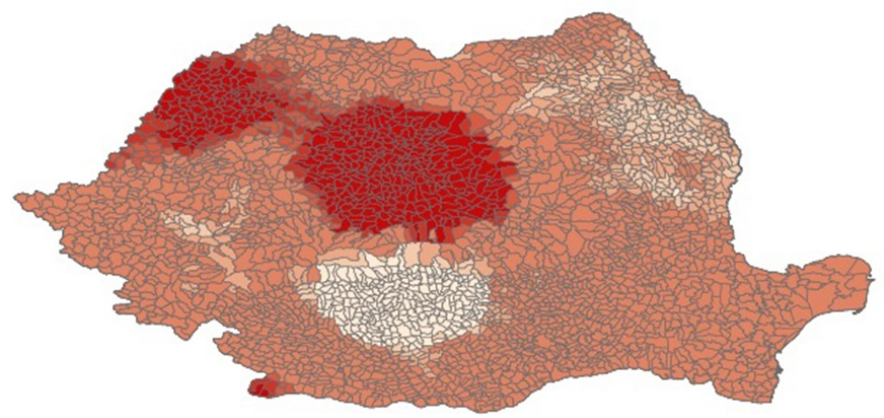
Figure 5. Hot Spot Analysis for Cumulative Risk. Hot spot analysis visualization of cumulative need across the country. Including all significantly auto-correlated parameters, with the addition of the measure of severe poverty, need of any kind is significantly auto-correlated in Romania (z-score = 11.5, p-value < 0.0001) and most apparent in the central portion of the country and extending to the North-West corner (dark red). These areas correlate with locations of Roma communities.